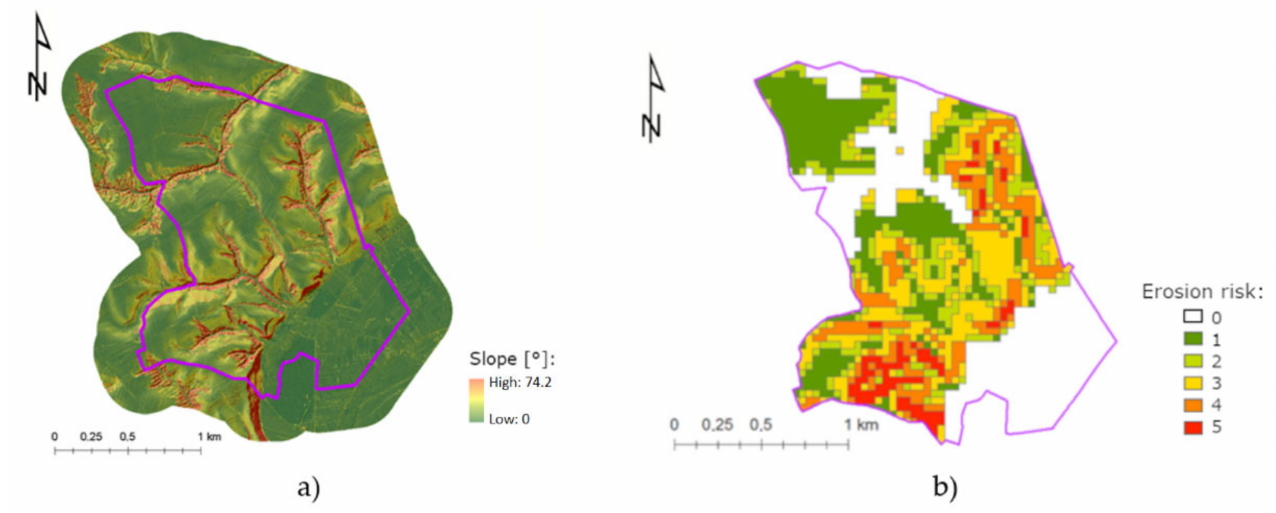
Figure 3. Winiarki research area: slope map with hill shade effects (data source: ALS DTM processing—1 m × 1 m spatial resolution) ( a ) and water erosion risk based on the IUNG expert classification from level 0—no risk to level 5—very high risk: 40 m × 40 m spatial resolution ( b